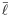
Influence of cell bond tension on clone shape.(A-K) The first and third rows represent examples of final configurations of networks of cell bonds of a clone (blue) in a tissue. The second and fourths rows depict clonal roughness for clone sizes N = 30, 60, and 100 cells as a function of segment length L. Segment length and clonal roughness values are normalized by the average cell bond length in the tissue l¯. Mean and s.e.m. are shown (n = 30 realizations for each case and parameter value). (A,B) Reference case: All cells and cell bonds have the same properties. (C-F) Case I: Cell bond tension at the clone border is increased by a factor λ = 2 or decreased by a factor of 2 (λ = 0.5). (G-I) Case II: Cell bond tension in all cells of the clone is increased by a factor α = 2 or decreased by a factor of 2 (α = 0.5). (J,K) Case III. Cell bond tension at the clone border is increased by a factor λ = 2 and cell bond tension in all cells of the clone is decreased by a factor of 2 (α = 0.5). (L) Average clone cell number after five generations for the reference and the cases shown in (C-K). Mean and s.e.m. are shown (n = 2500 realizations for each case and parameter value).